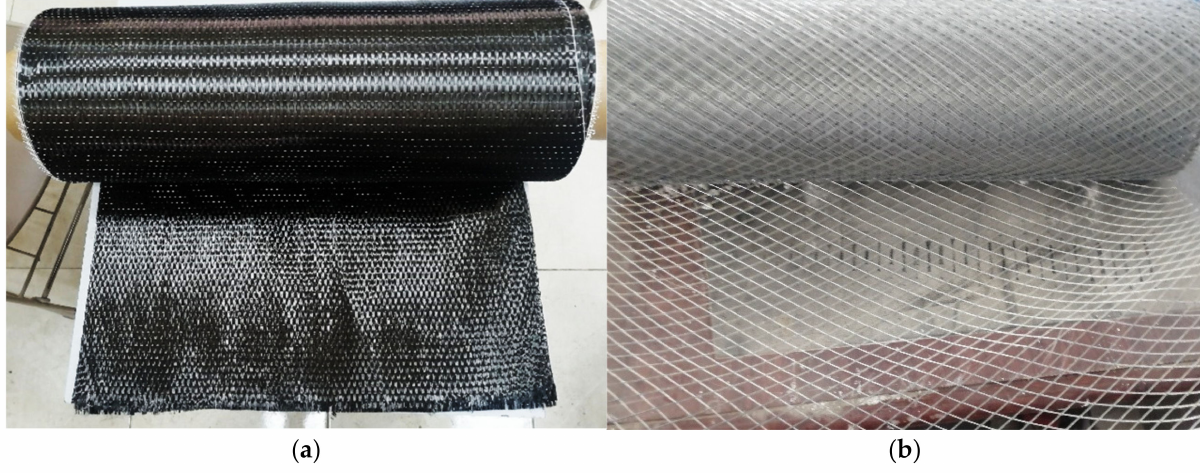
Figure 3. The shape of strengthening materials. ( a ) CFRP laminates, ( b ) welded wire